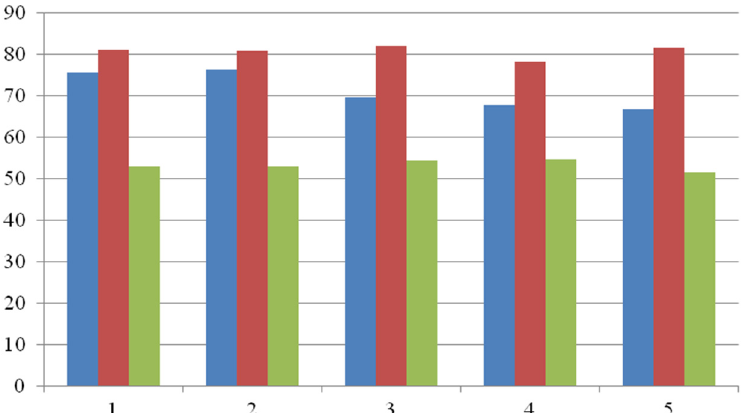
Figure 8. Reusability of catalyst. Reaction conditions: FAME content of 1 wt%; temperature of 40 °C; catalyst content of 15 g·L − 1 ; unsaturated FAME:H 2 O 2 molar ratio of 1:2; reaction time of 4 h;